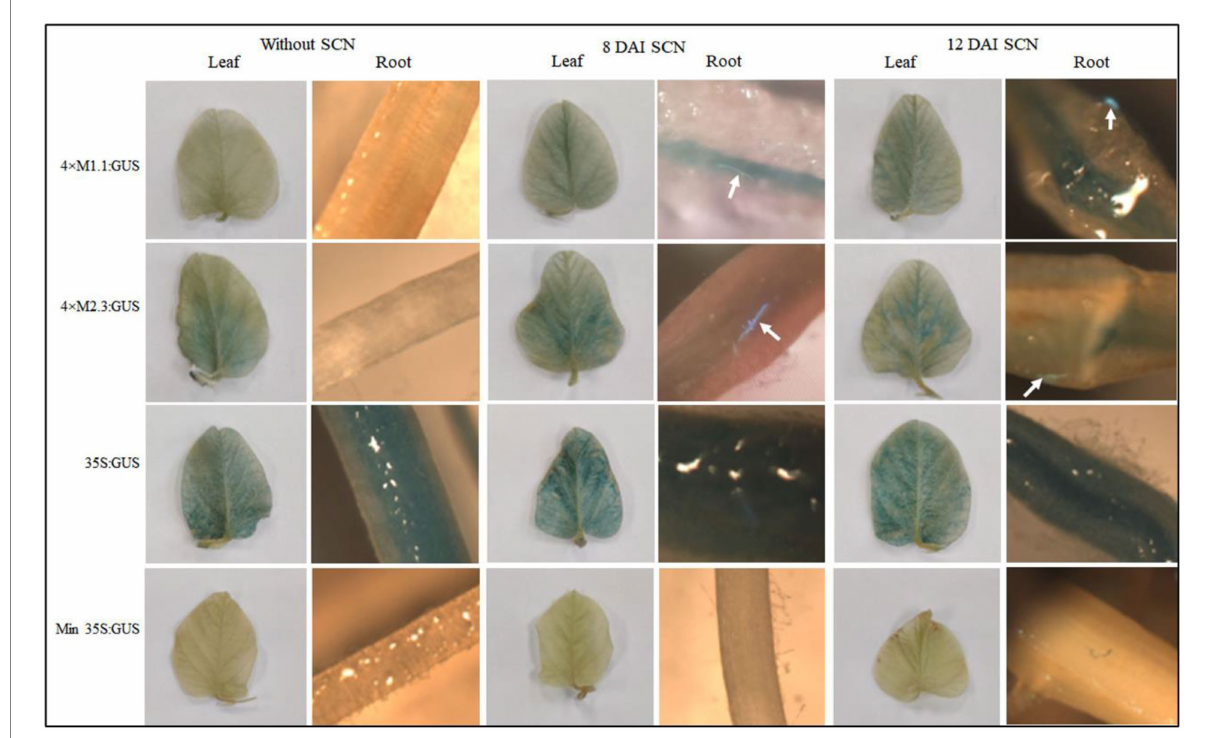
FIGURE 2 Histochemical GUS activity in leaves and roots of transgenic soybean containing the individual promoter-GUS construct uninfected or infected with soybean cyst nematode (SCN, Heterodera glycines ) at 8 and 12 days after inoculation (DAI). Arrows indicate localized GUS expression within the nematode-induced feeding sites. Three independent transgenic lines and six plants from each line were used for 4 × M1.1 and 4 × M2.3 promoter-GUS constructs. One transgenic line and six plants from the transgenic line were used for 35S and minimal (Min) 35S promoter-GUS constructs. A similar GUS expression was observed from each